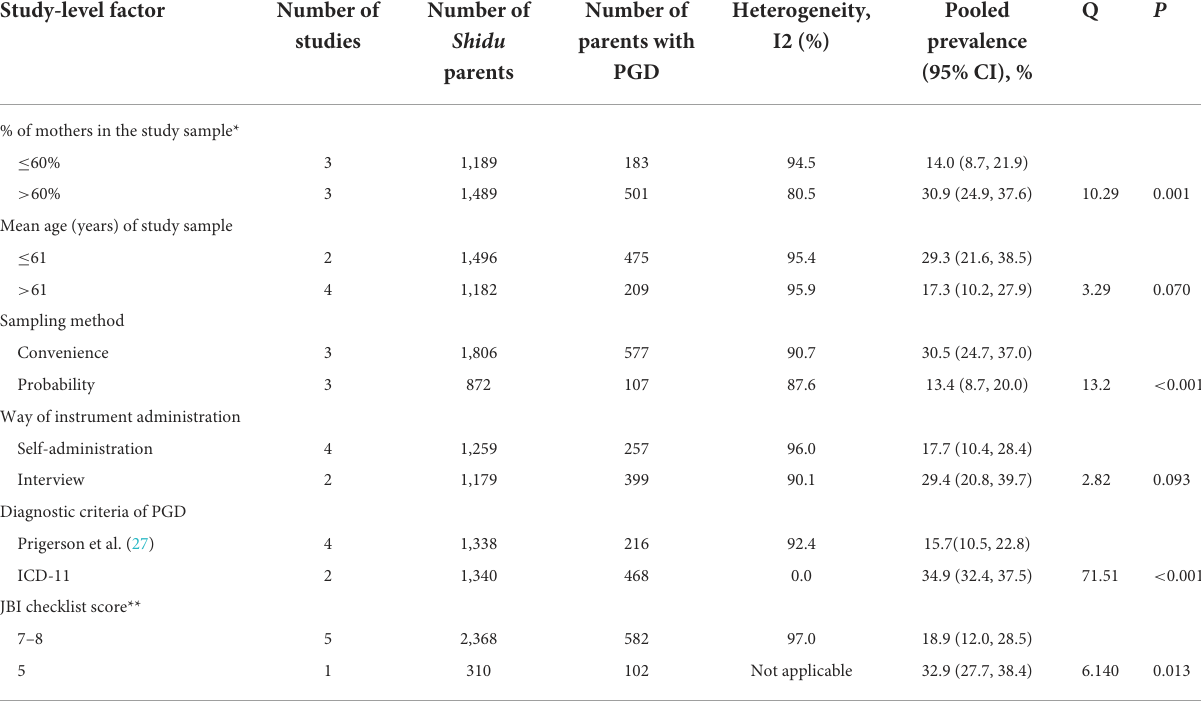
TABLE 2 Subgroup analyses of meta-analysis of prevalence of Prolonged Grief Disorder (PGD) according to study-level factors. Study-level factor Number of